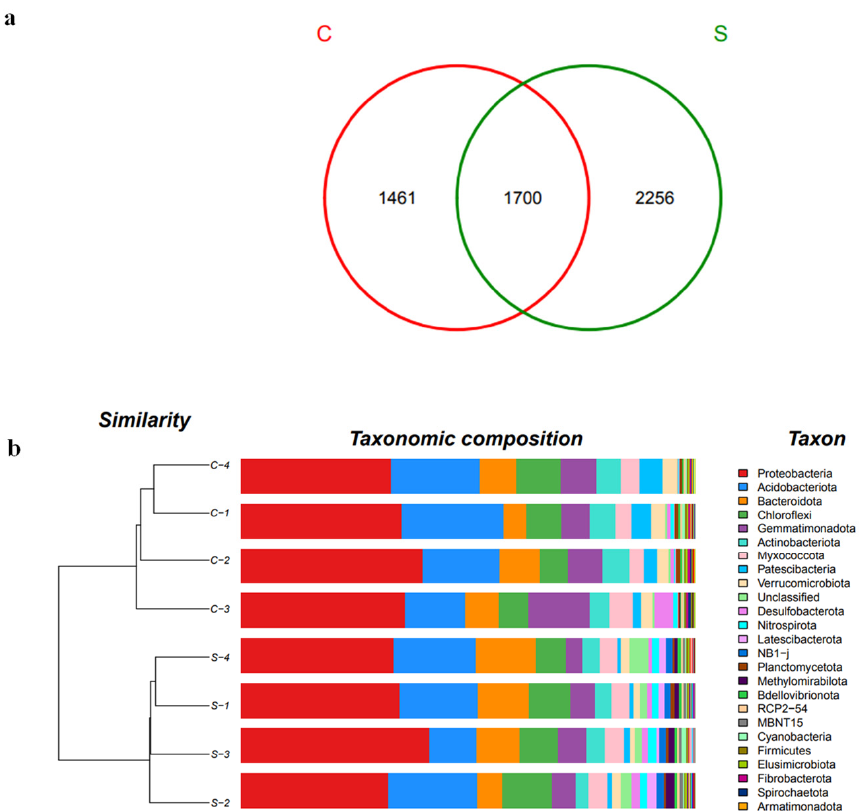
Figure 6. Venn diagram and taxonomic distribution of microbial community. ( a ) Venn diagram; ( b ) Taxonomic distribution.